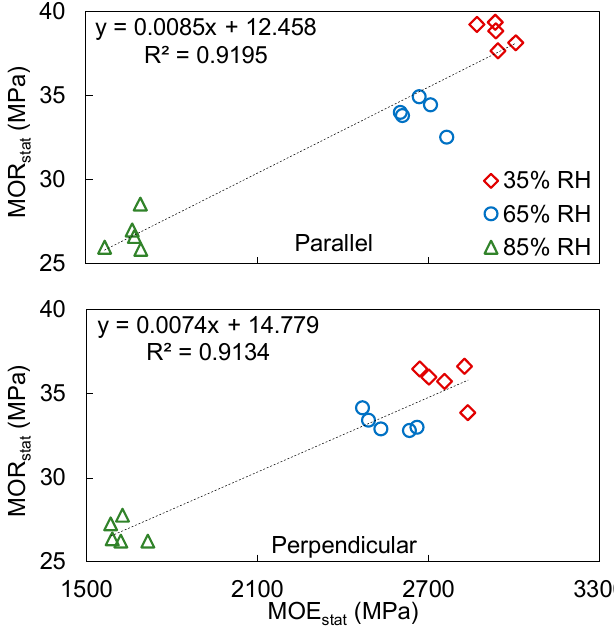
Figure 2. Linear relationship between MOE stat and MOR stat of the Medite Tricoya ® medium density fiberboard (MDF) samples in two different directions conditioned at three different climatic conditions.